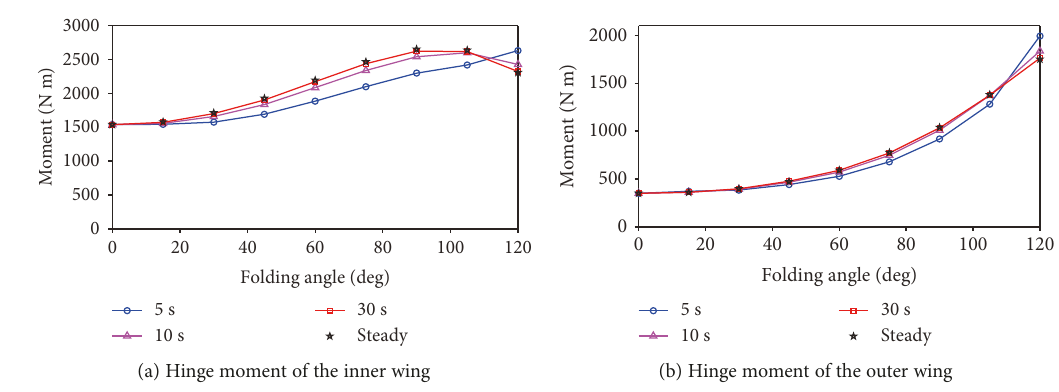
Figure 10: Comparison of hinge moments at di ff erent folding